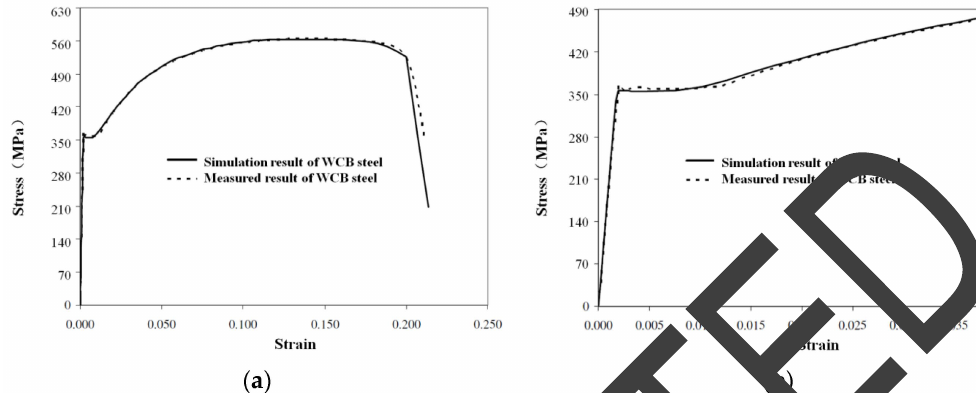
Figure 7. Tensile result comparison of the matrix specimen between test and simulation. ( a ) Complete tensile result curves; ( b ) Curves after scaling up.